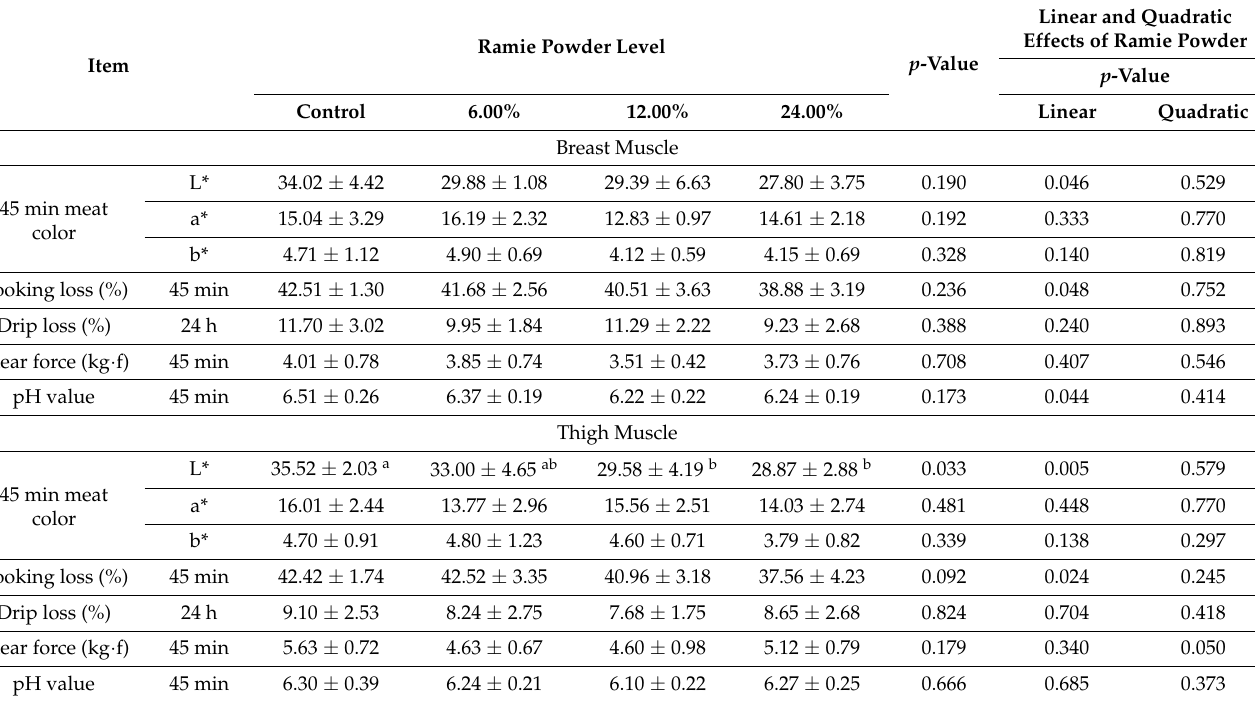
Table 4. Effect of the different ramie powder levels in the diets on the meat quality of the Yanling white geese muscle (98 d).